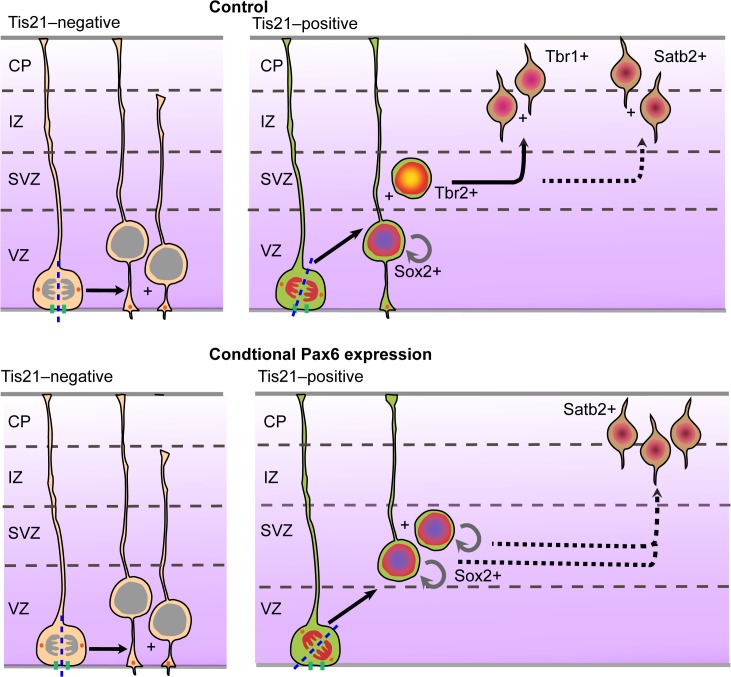
Model.Cartoon showing the effects of conditional Pax6 expression on Tis21-positive APs.